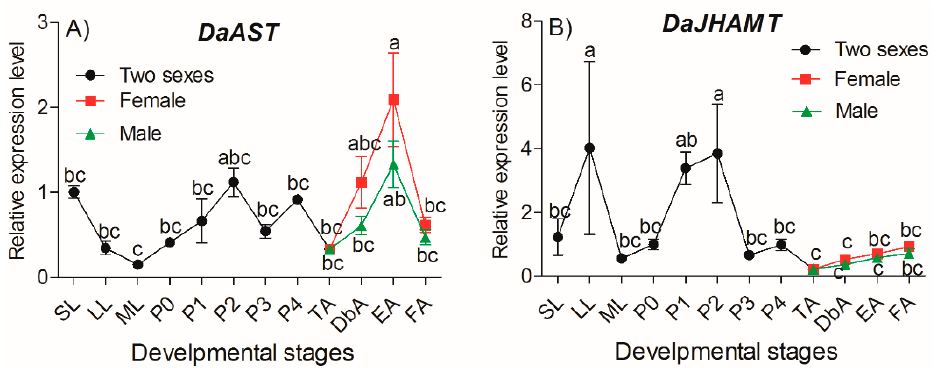
Figure 3. Relative expression of DaAST and DaJHAMT genes in different stages of D. armandi . ( A ) DaAST ; ( B ) DaJHAMT. Small larvae (SL), large larva (LL), mature larvae (ML), pupae (P0, P1, P2, P3, P4), teneral adults (TA), dark brown adults (DbA), emergent adults (EA) and feeding adults (FA) of D. armandi . The results represent the mean ± SE of three independent experiments. All templates were normalized with CYP 4G55 and β -actin . The 2 −ΔΔ Ct and SE values were used for plotting and the significant differences between different stages of DaAST or DaJHAMT were marked with letters (one-way ANOVA, p < 0.05, with Tukey’s test of multiple comparisons).